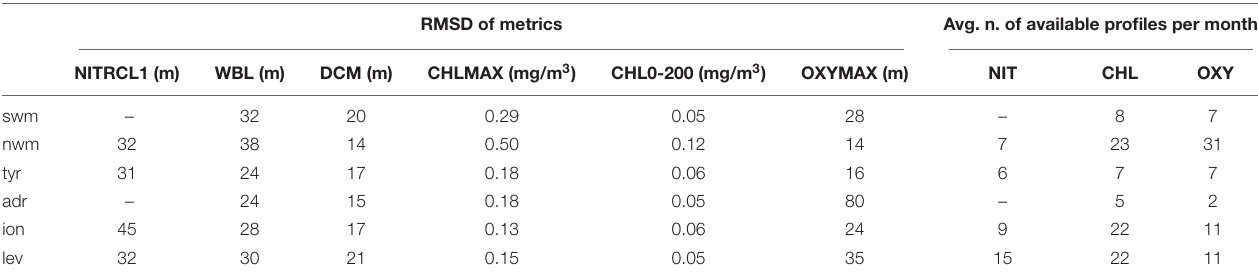
TABLE 3 | Metrics computed for the level-3